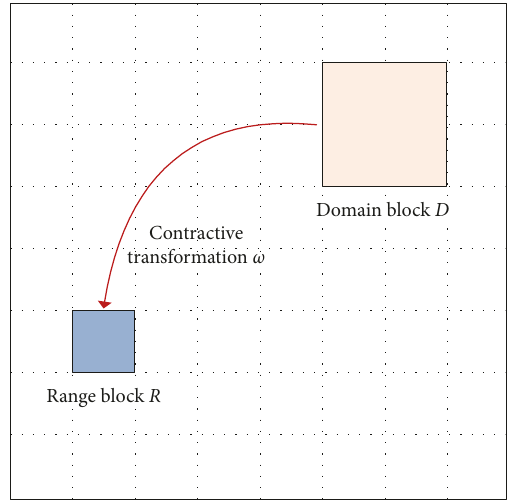
Figure 1: Block mapping of fractal